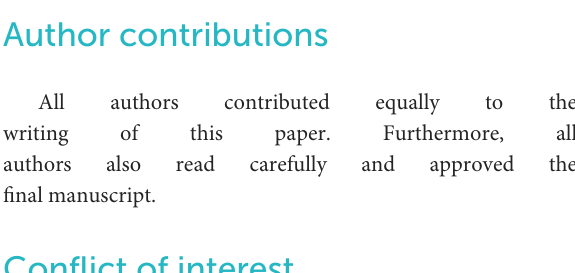
T when 1τ does not satisfy the stability condition (Equation 28) for =